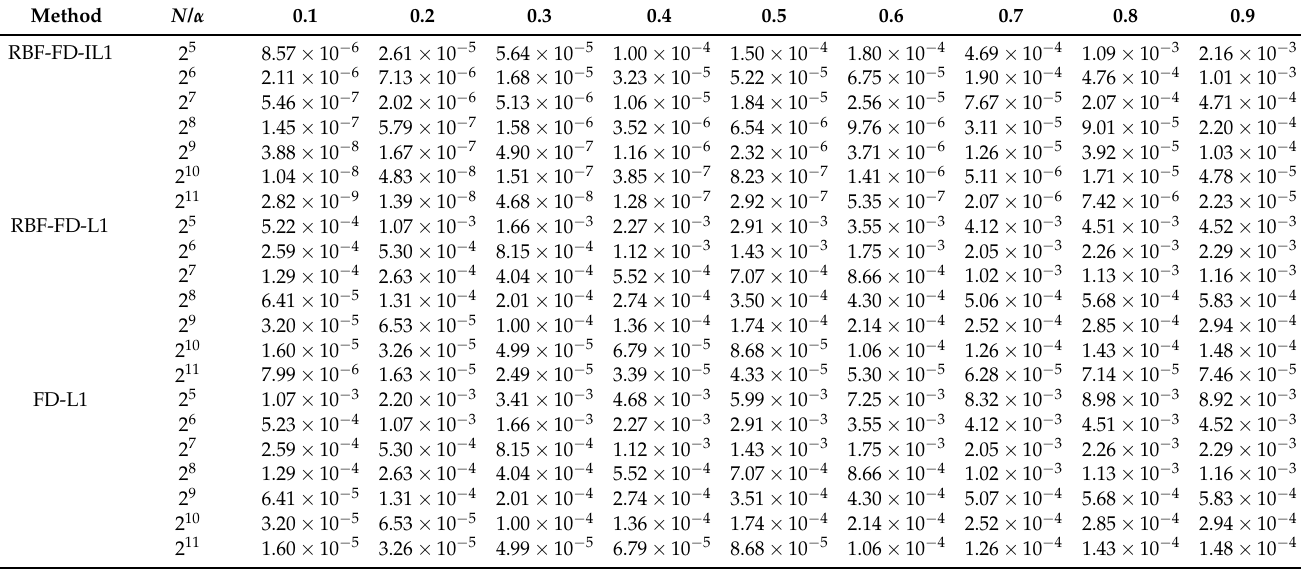
Table 2. The numerical error for European put options using the RBF-FD-IL1, RBF-FD-L1 and FD-L1 methods with M = 2 9